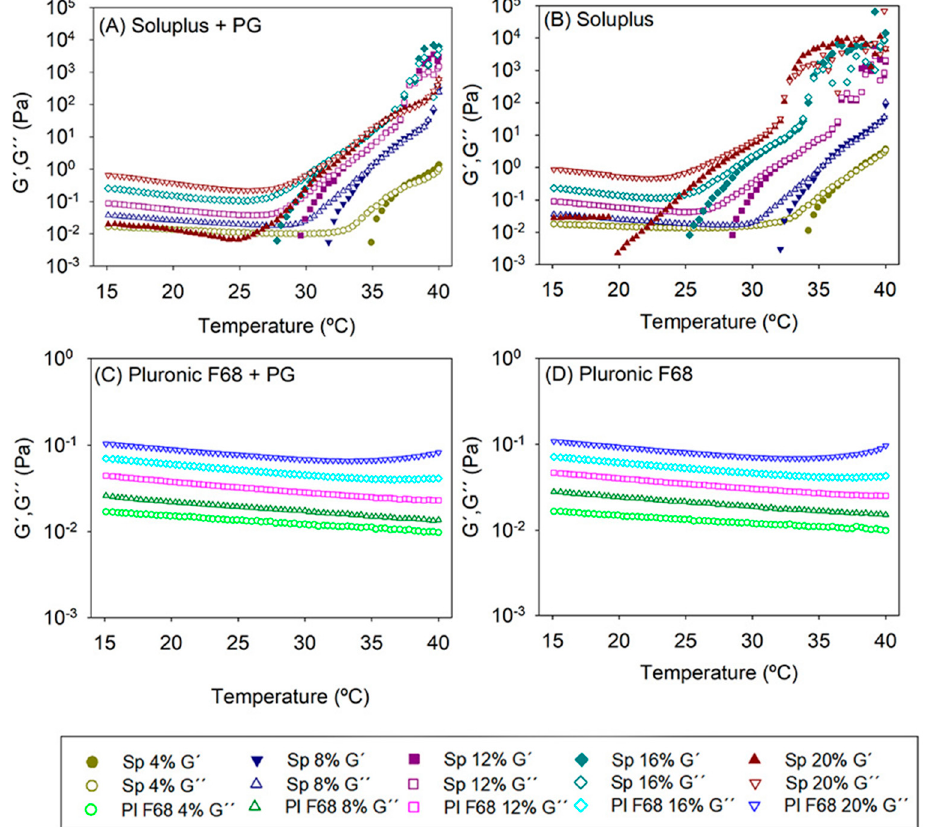
Figure 2. Evolution of the storage (G ′ ) and the loss (G ′′ ) moduli as a function of temperature of ( A ) PG-loaded Soluplus micelle dispersions, ( B ) blank Soluplus dispersions, ( C ) PG-loaded Pluronic F68 micelle dispersion, ( D ) blank Pluronic dispersions. Total copolymer concentration was 4, 8, 12, 16, and 20% w / w in a PBS pH 7.4 buffer ( n = 4).